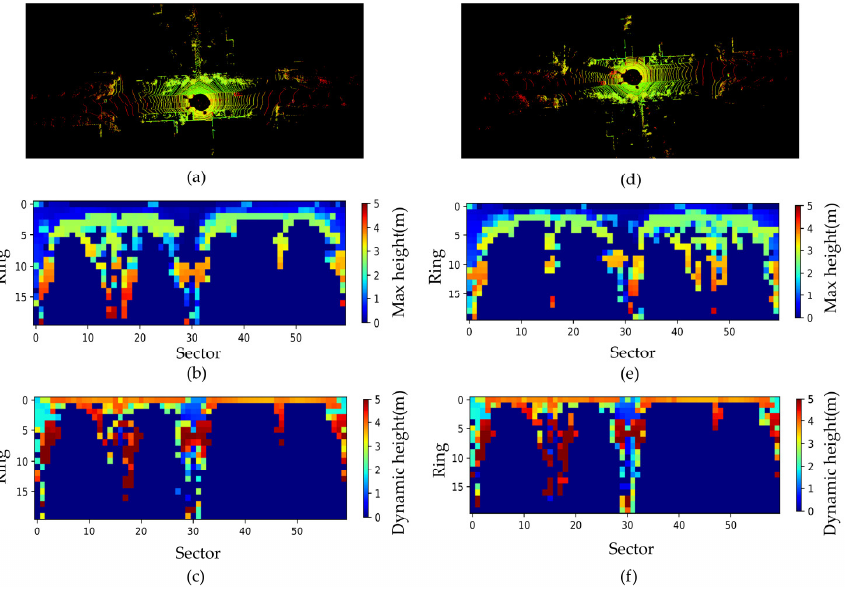
Figure 11. Descriptors in real scenarios. ( a ) The point cloud at frame 756 of KITTI-08. ( b ) The descriptor generated by SC of ( a ) and different color means max height (from 0 to 5 m). ( c ) The top-view projection of 3PCD-TP of ( a ) and different color means dynamic height (from 0 to 5 m). ( d ) The point cloud at frame 1452 of KITTI-08 which can form loop closure with frame 756. ( e ) The descriptor generated by SC of ( d ). ( f ) The top-view projection of 3PCD-TP of ( d